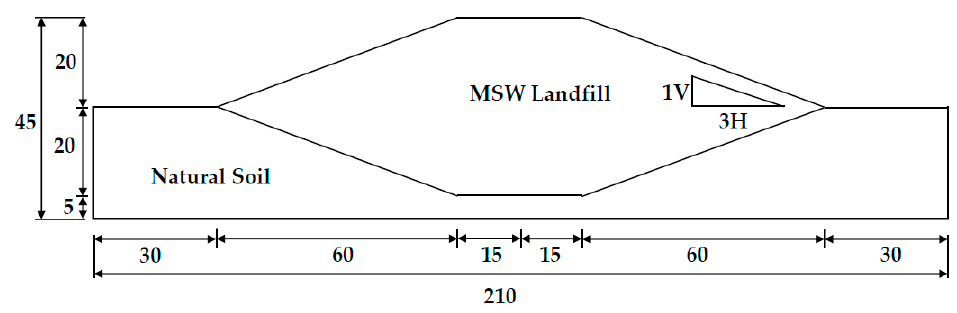
Figure 1. Landfill geometry for 1V/3H (dimensions are in meters).